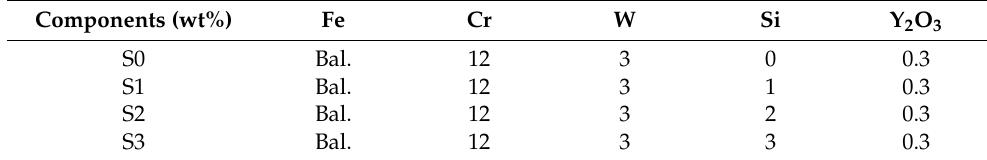
Table 1. Four components of elemental powders. Components (wt%) Fe